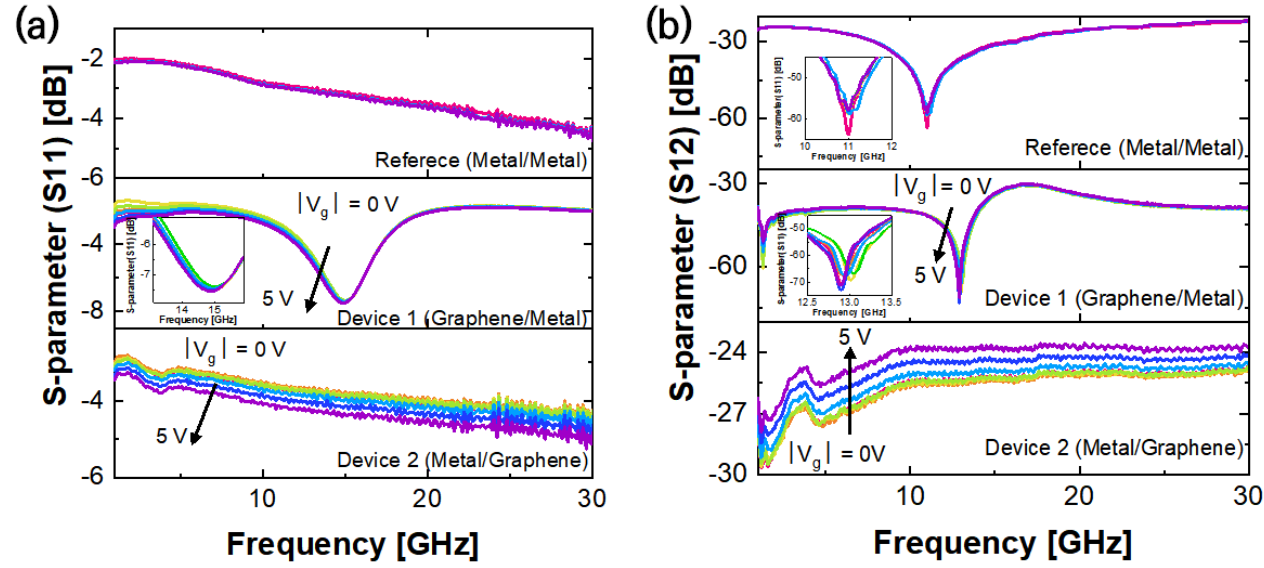
Figure 3. S-parameter measurement results with gate bias control. ( a ) Reflectance (S11) and ( b ) trans- ( b ) transmittance miance (S12).